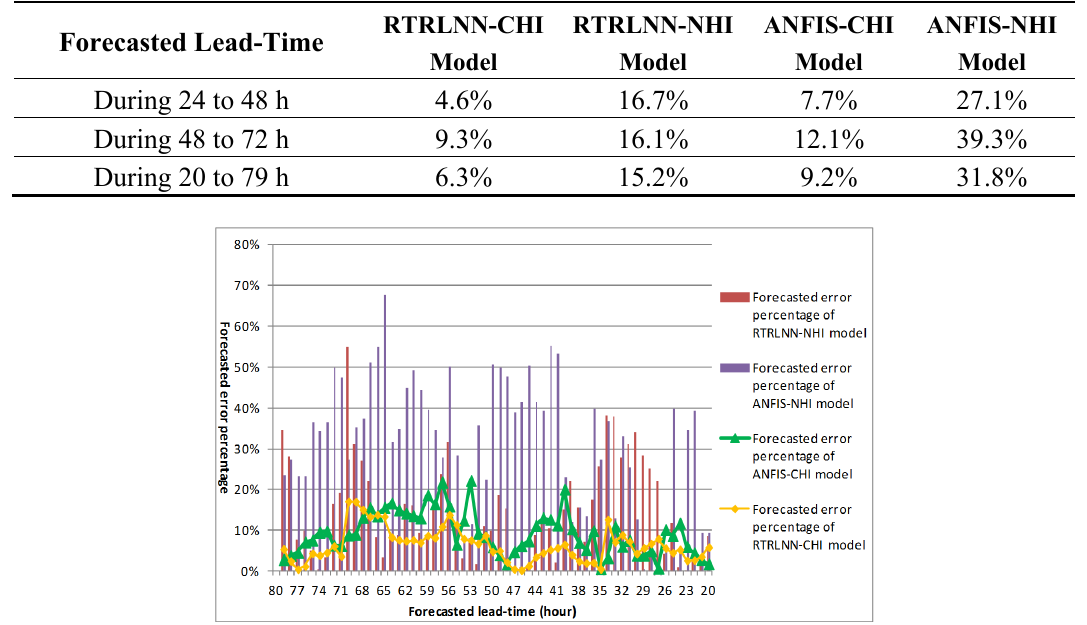
Figure 13. Comparison of temporal forecasted error features of the four developed accumulated total inflow forecast models across long